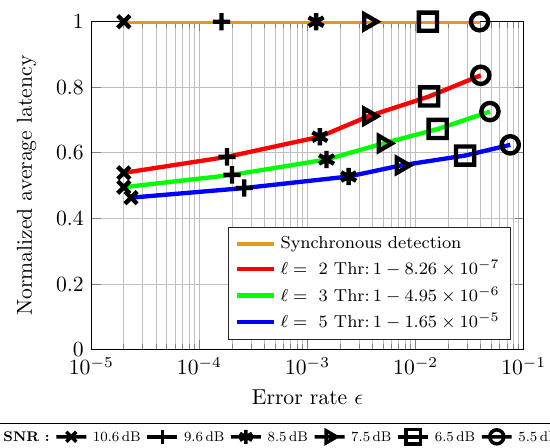
Fig. 7 Normalized average latency of the proposed early‑detection scheme compared to that of a synchronous‑detection scheme under various channel conditions. The proposed detection scheme combines a list decoder with list size ℓ and a MSPRT, whose threshold (Thr) is indicated in the